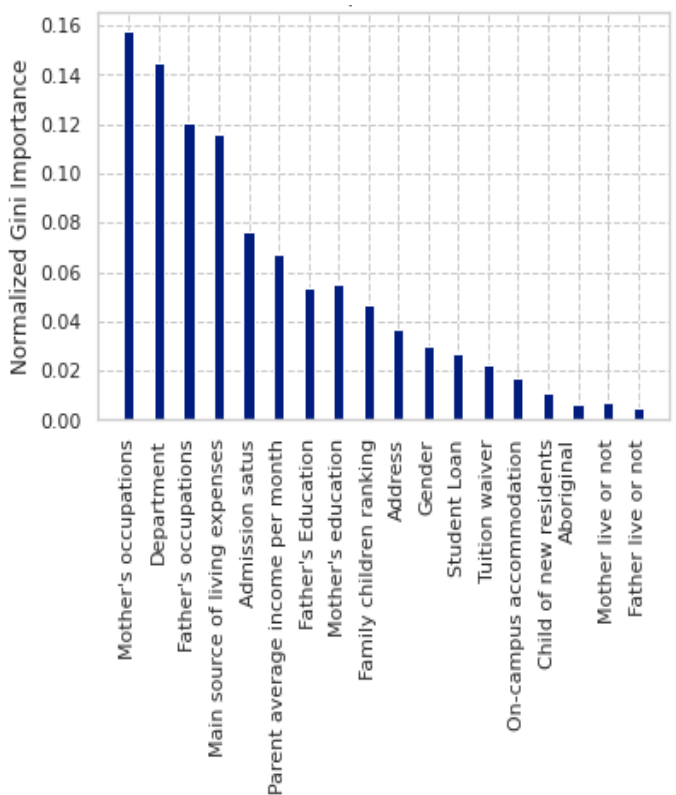
Figure 2. Gini importance from CART for Case 3: Ex- Poor classification.